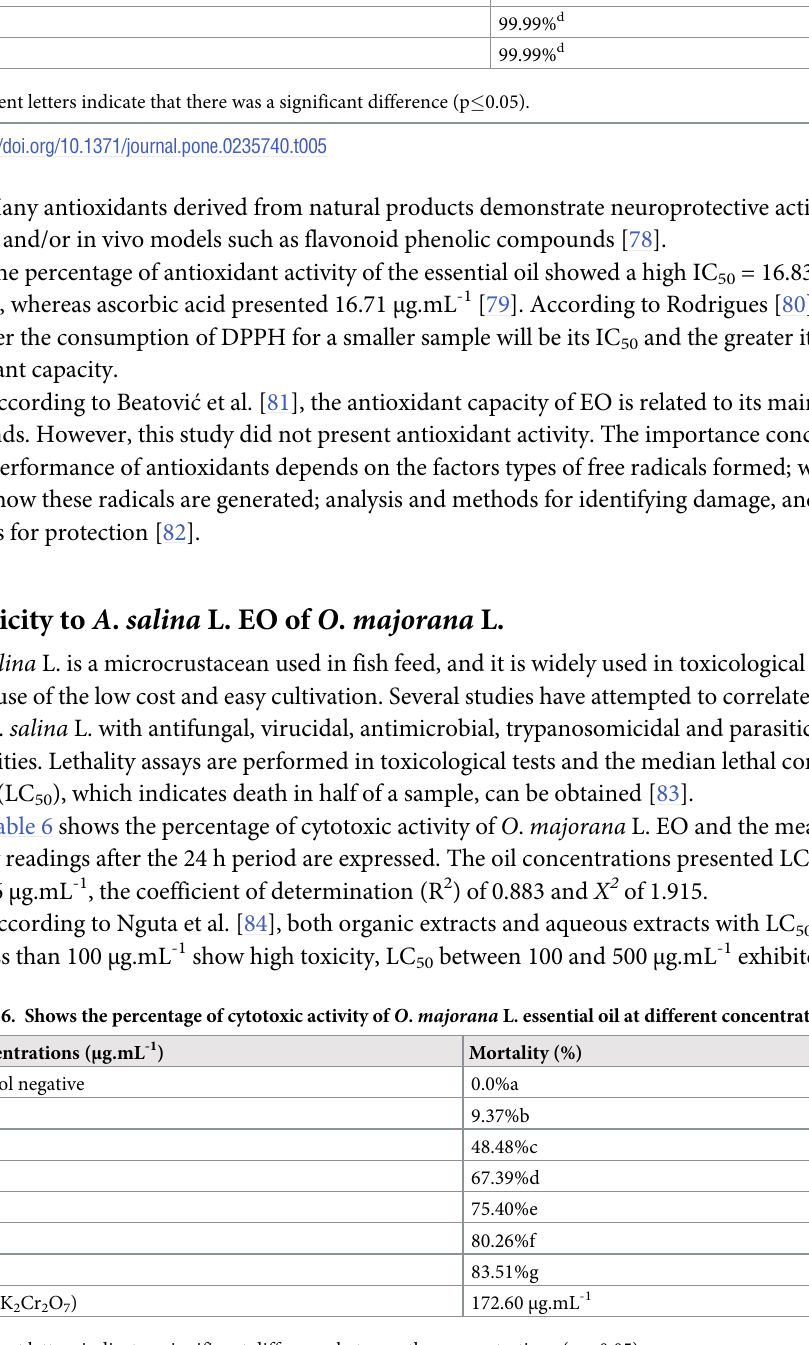
LC 50 (K 2 Cr 2 O 7 ) 172.60 μ g.mL -1 Different letters indicate a significant difference between the concentrations (p <